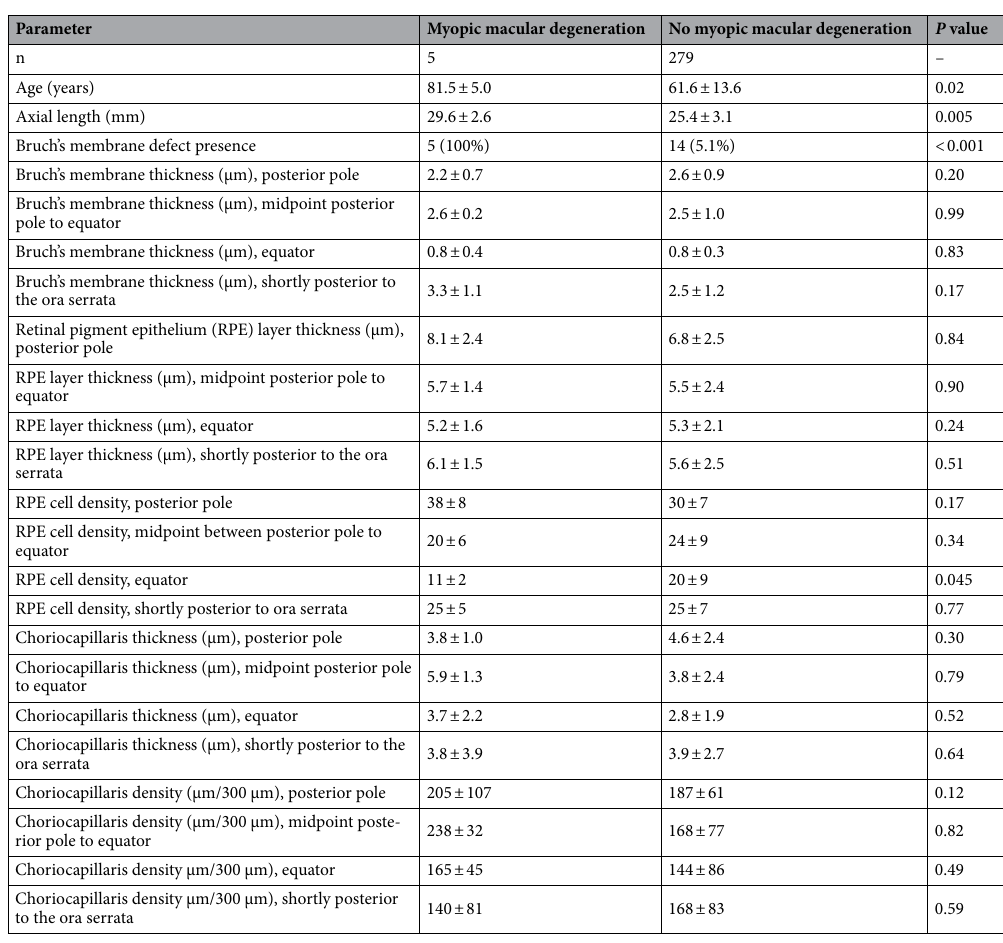
Table 1. Histomorphometric measurements (mean ± standard deviation) of eyes with neovascular myopic macular degeneration (nMMD) versus eyes with